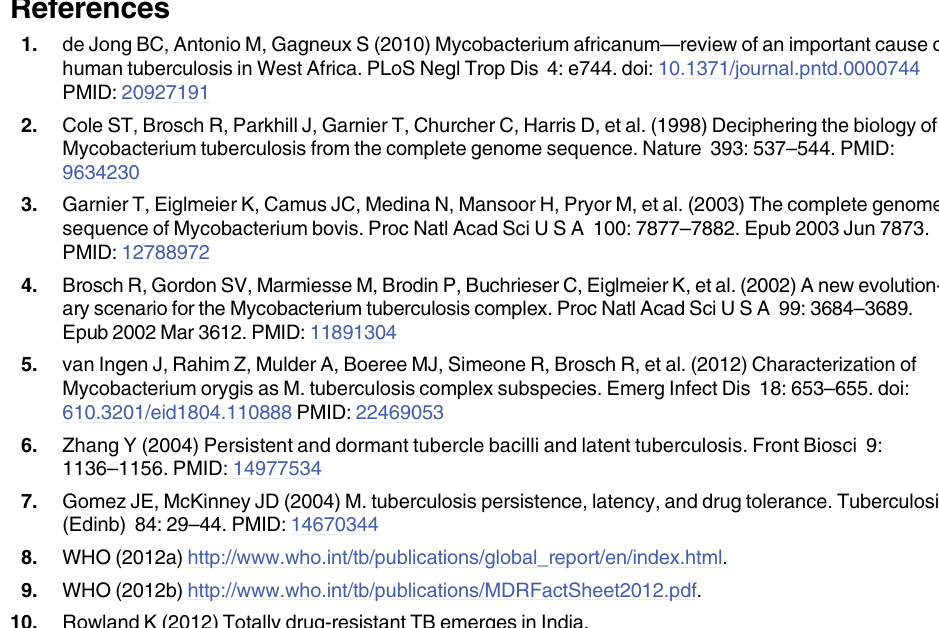
S2 Table. Primers used. List of forward and reverse primers used for the validation and their expected product